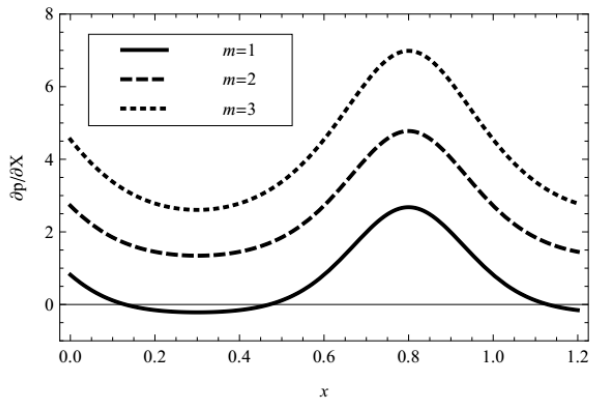
Figure 2. Profiles of the pressure gradient for various values of m with fixed α = 0.4, β = 0.6, λ 1 = 1, λ 2 = 1, U HS = 1, φ = 0.3, Q = 0.1, t = 0.8.